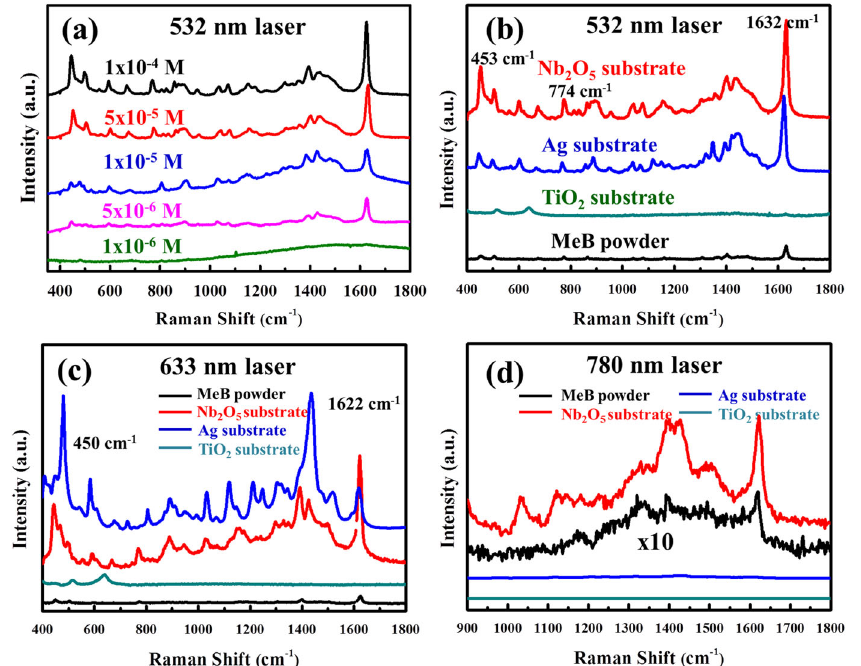
Fig. 2 a SERS signals of MeB molecules with various concentrations excited by laser of 532 nm on Nb 2 O 5 substrates. b – d Raman spectra of solid MeB powders and MeB molecules at a concentration of 5 × 10 – 5 M collected on Nb 2 O 5 , TiO 2 semiconductor, and Ag substrates with the incident laser of 532, 633 and 780 nm lasers, respectively